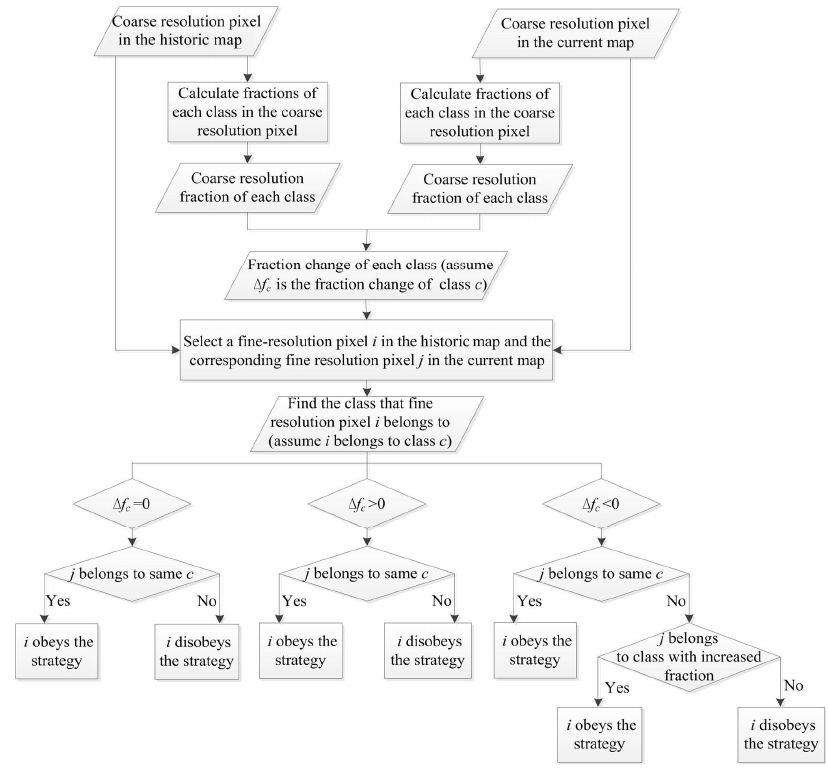
Figure 4. The flowchart used to judge whether a fine resolution pixel within a coarse resolution pixel obeys the change strategy or not.